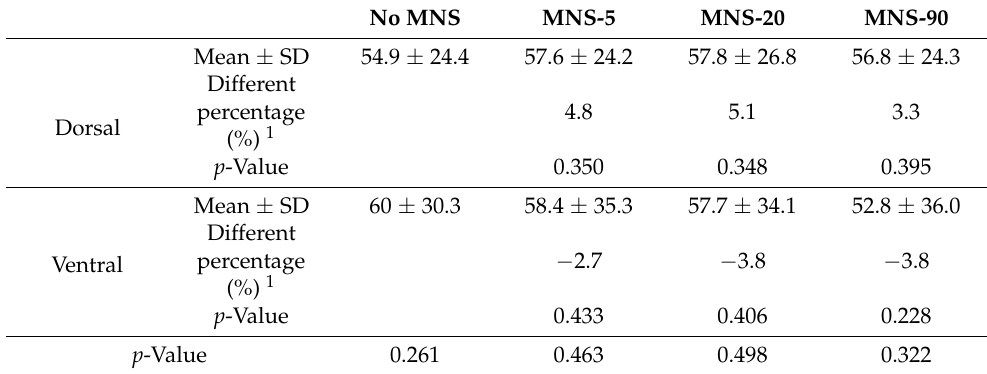
Table 3. The firing rate under no MNS, MNS-5, MNS-20, and MNS-90; Student’s t-test was used to compare the differences between no MNS and different frequencies of MNS. In addition, the firing rates between dorsal and ventral STN are compared for all groups.